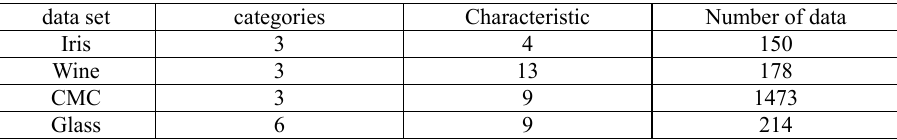
Table 2. UCI data set details.